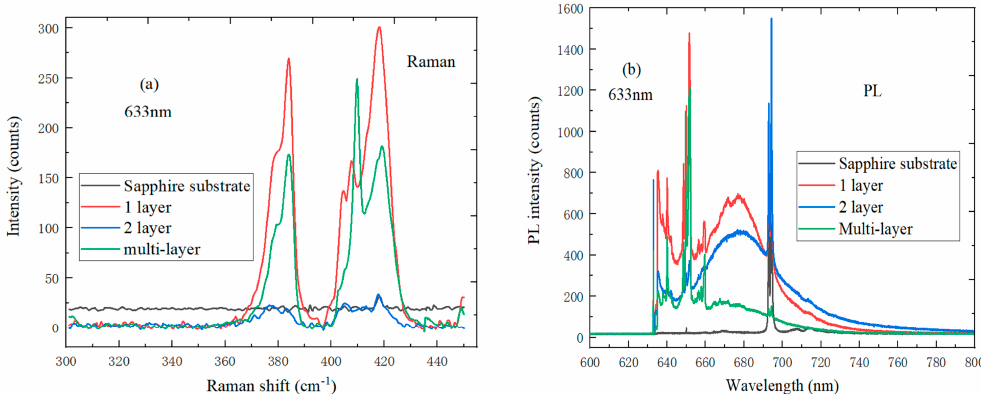
Figure 7. ( a ) Raman spectrum of MoS 2 with different layers on the sapphire substrate; ( b ) PL spectrum of MoS 2 with different layer on the sapphire substrate under the laser wavelength of 633 nm.